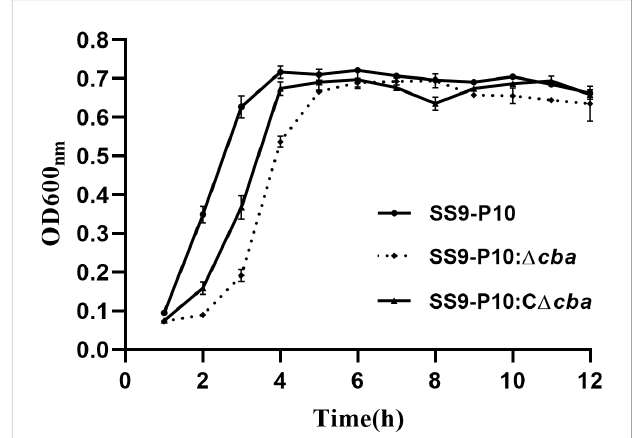
FIGURE 2 Growth curve before and after cba gene deletion, and the survival curve of mice during a challenge. Deletion and deletion complementation of the cba gene does not affect the growth of SS. All three strains entered the logarithmic growth phase after 2 h and reached the plateau phase after about 4